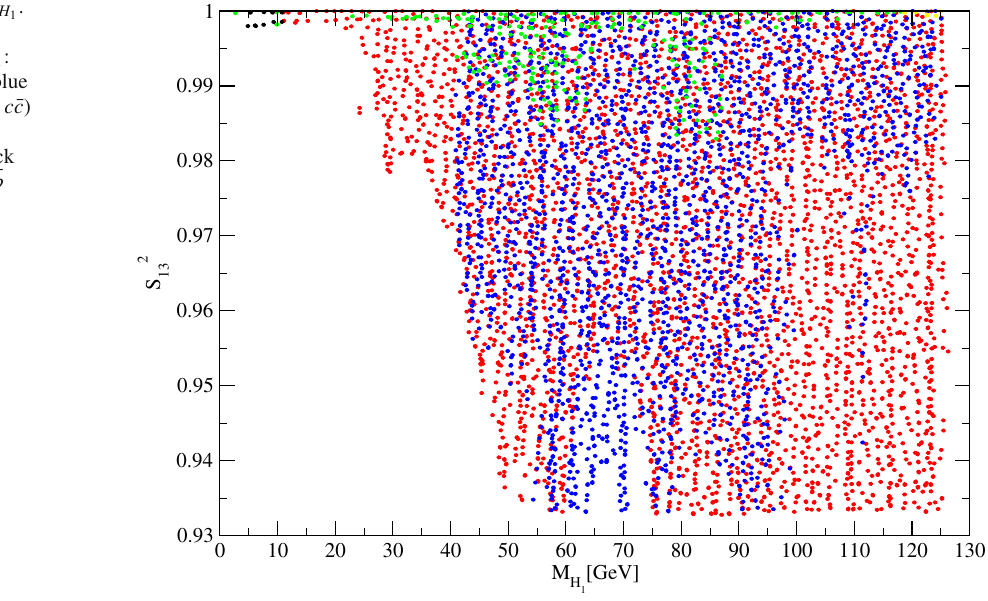
Fig. 3 Masses of the chargino χ ± ( a ) and the left-handed stau ˜ τ L ( b ) as function of the left-handed smuon mass. The color code is as in Fig. 2 1